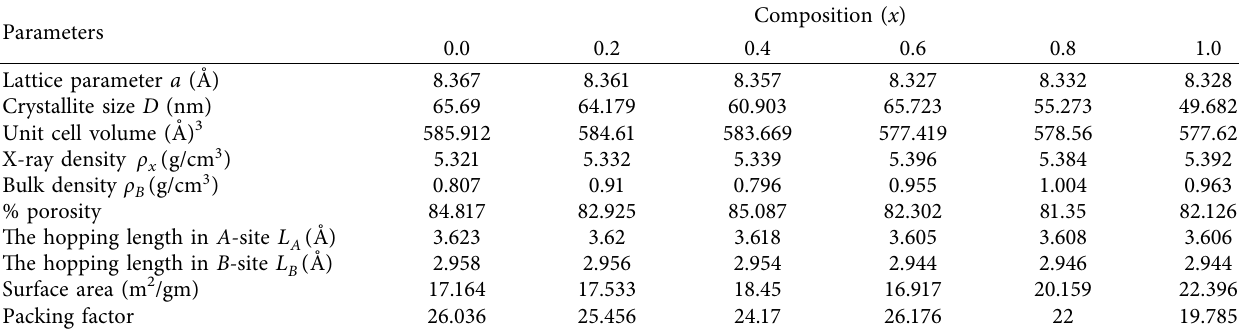
Table 2: Calculated values of various structural parameters for Co (311) at T � 800 °